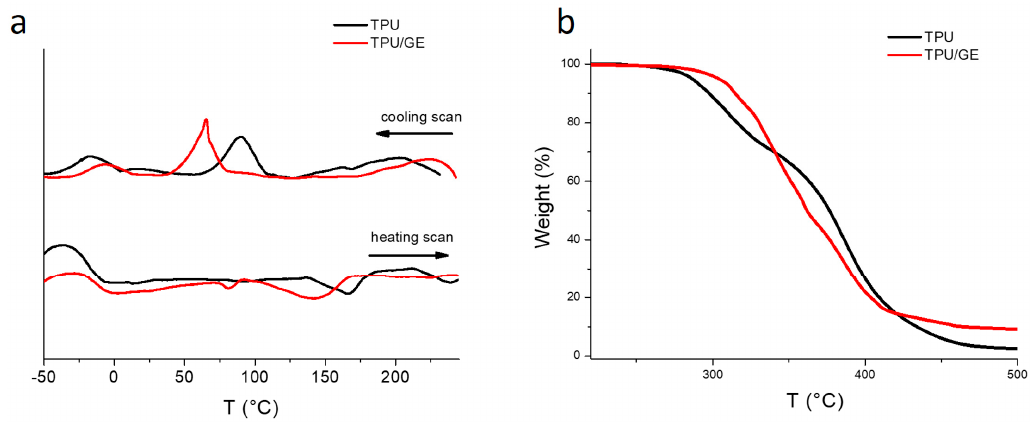
Figure 5. ( a ) DSC and ( b ) TGA curves of SLS fabricated TPU and TPU/GE